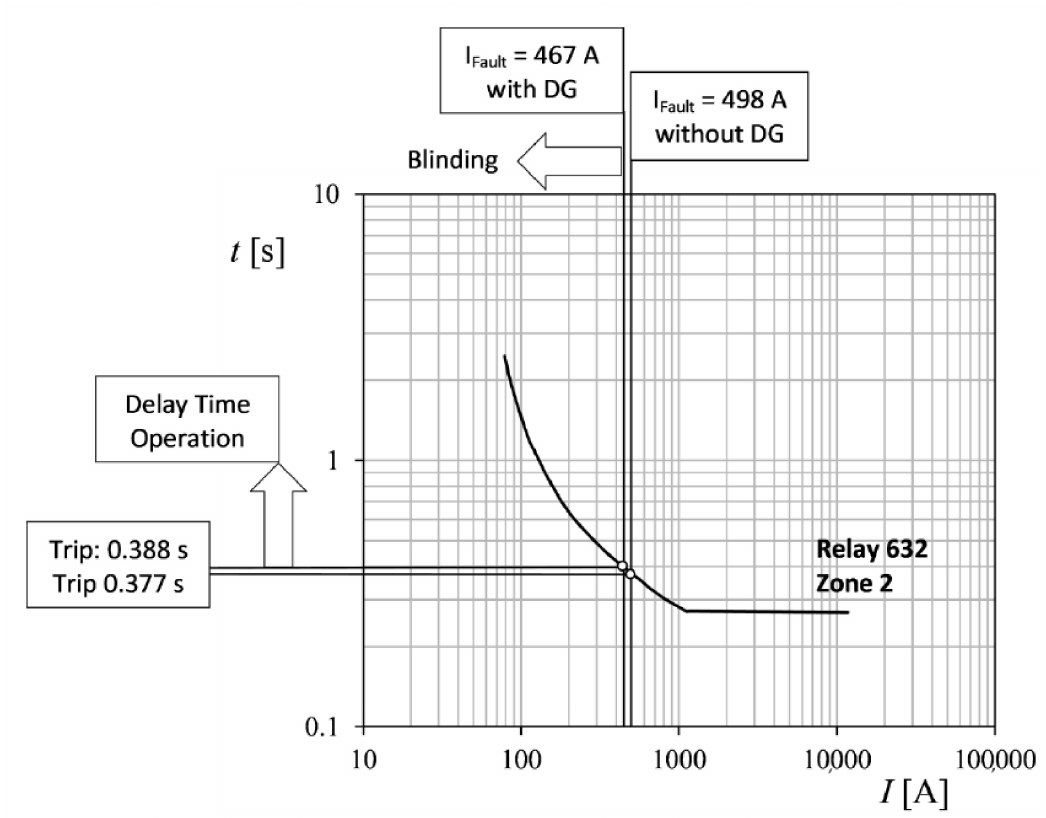
Figure 8. Protection Zone 2 current-time ( I-t ) performance in case of a three-phase short-circuit at point F2, with 50% DG power (2 MW) at bus 633 (see Figure 6).